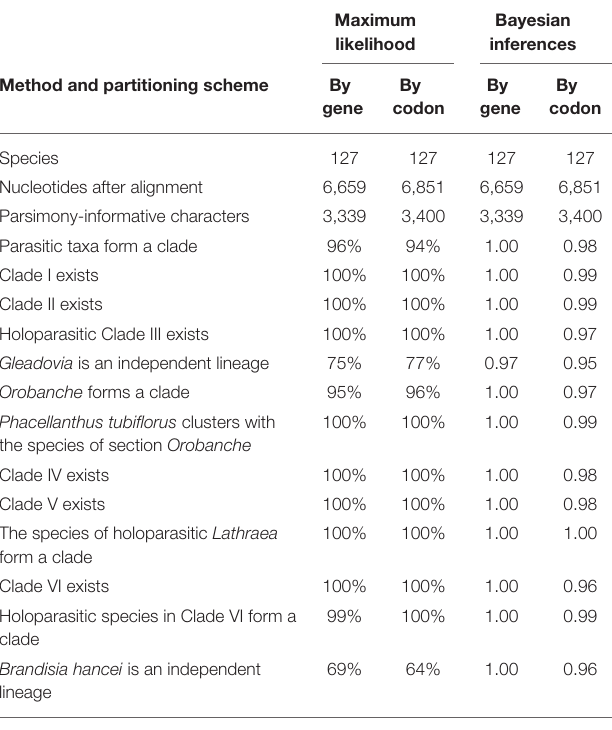
TABLE 1 | Summarized results of phylogenetic analyses in Orobanchaceae based on the combined five-gene